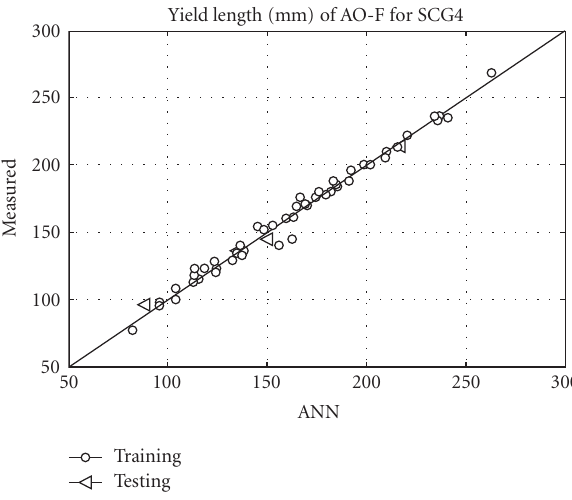
Figure 17: Comparison of the measured and predicted yield length based on temperature and pressure for Fe − 2Ni.